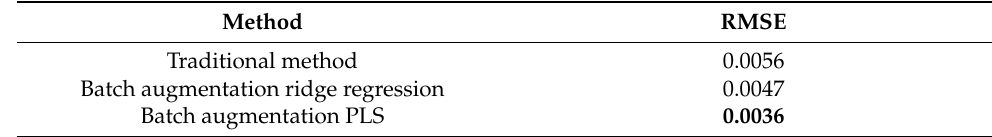
Figure 12. Average RMSE of online quality predictions. Table 5. Overall RMSE of online quality